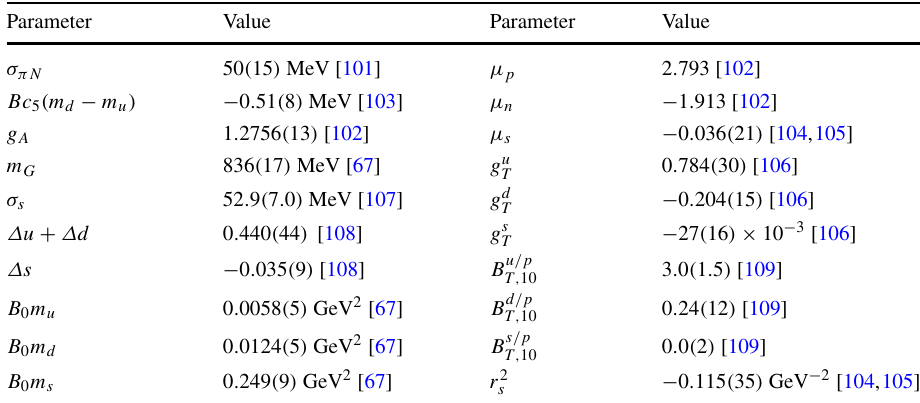
Table 3 The hadronic input parameters as used in DirectDM